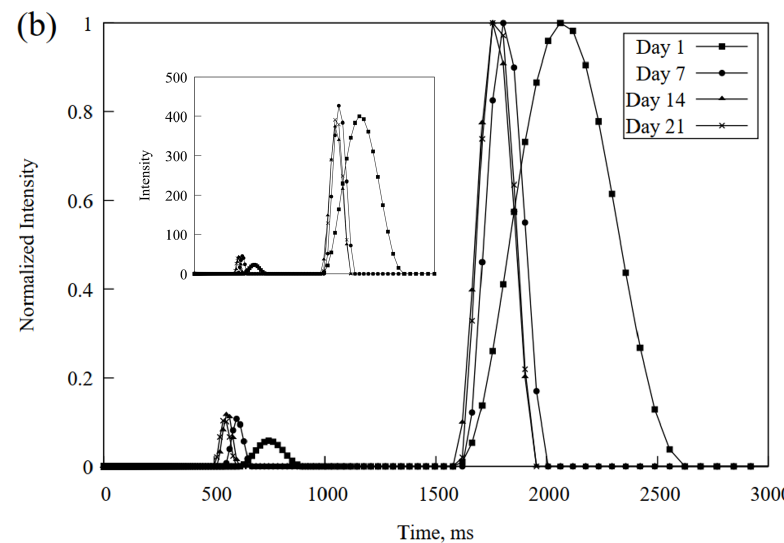
Figure 8. Relaxation time distribution (T 2 ) of glass beads saturated with 100% Na 2 SO 4 : ( a ) Untreated glass beads aged for 21 days at 25 ◦ C; ( b ) Treated glass beads aged for 21 days at 25 ◦